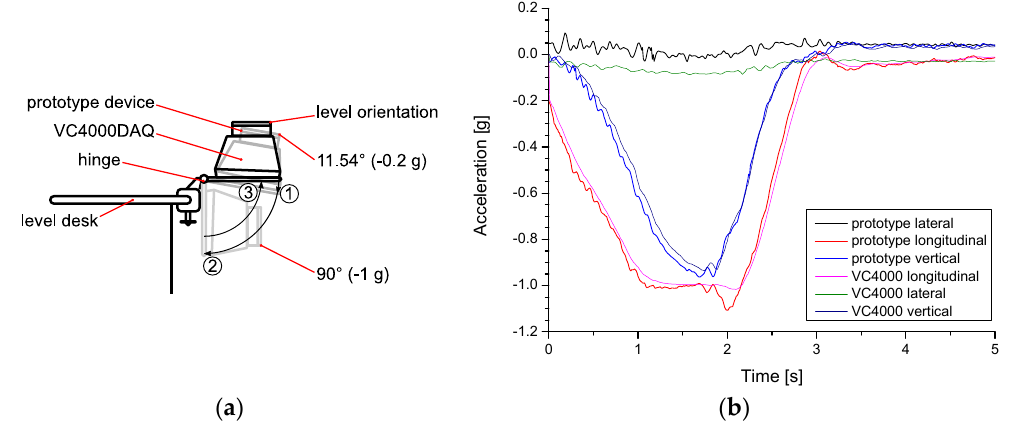
Figure 8. ( a ) Schematics of the tilting device; ( b ) Comparison of recorded acceleration time series during a test on the tilting device.